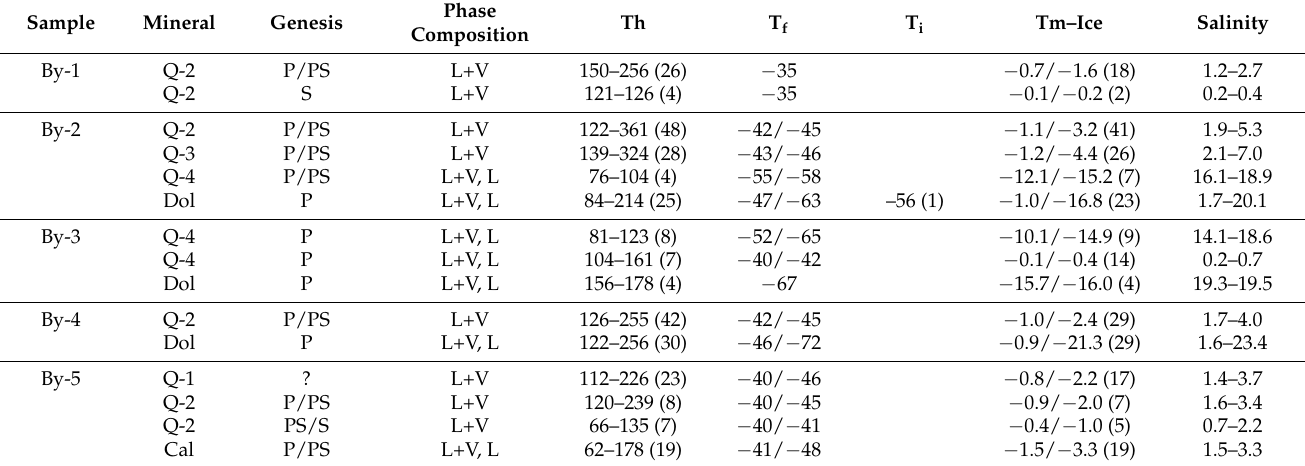
Table 1. Microthermometric data from fluid inclusions hosted by the studied Au-bearing vein from Byt í z. Temperature parameters in ◦ C, salinity in wt. % NaCl eq. Numbers in parentheses refer to number of